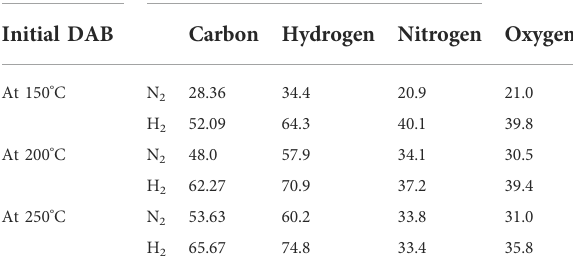
TABLE 4 HTL effects on elemental enrichment